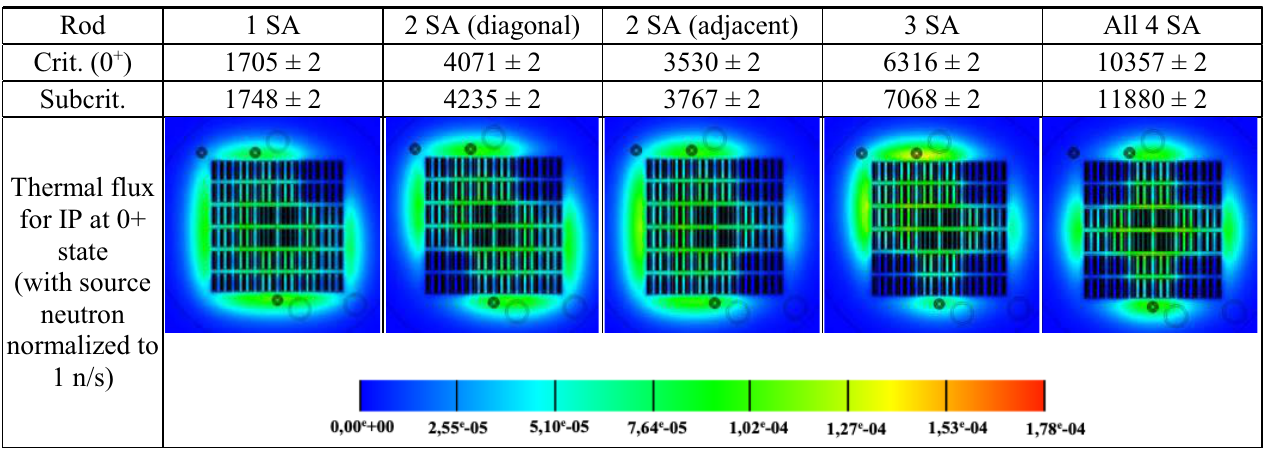
Table II. Safety absorbers worths (pcm with 2 6 ) & thermal flux calculated with TRIPOLI4 ®